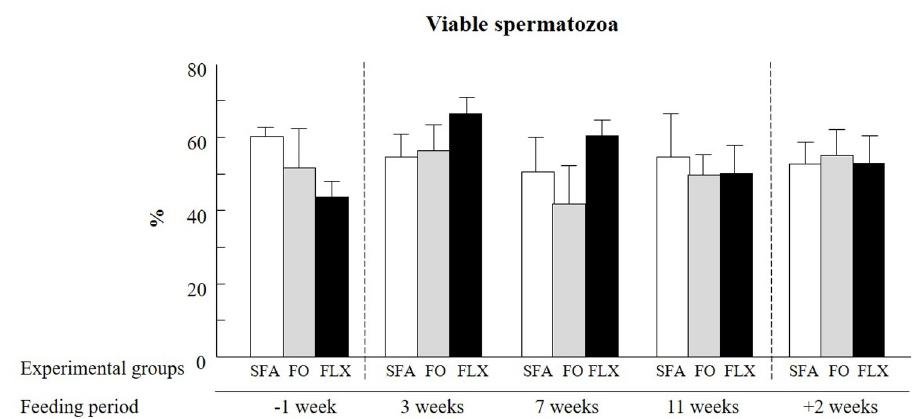
Fig 3. Effect of omega-3 sources flaxseed and fish oil on spermatozoa viability. The proportion of spermatozoa classified as viable, i.e., negative for propidium iodide (PI), as examined by flow cytometer. Experimental groups were fed saturated fatty acid (SFA; control), fish oil (FO), or flaxseed oil (FLX) supplements. Ejaculates were collected before (-1 week), during (3, 7, and 11 weeks), and after (+2 weeks) the feeding trial. Data are presented as the mean ± SEM calculated for 5 replicates with 5000 spermatozoa for each